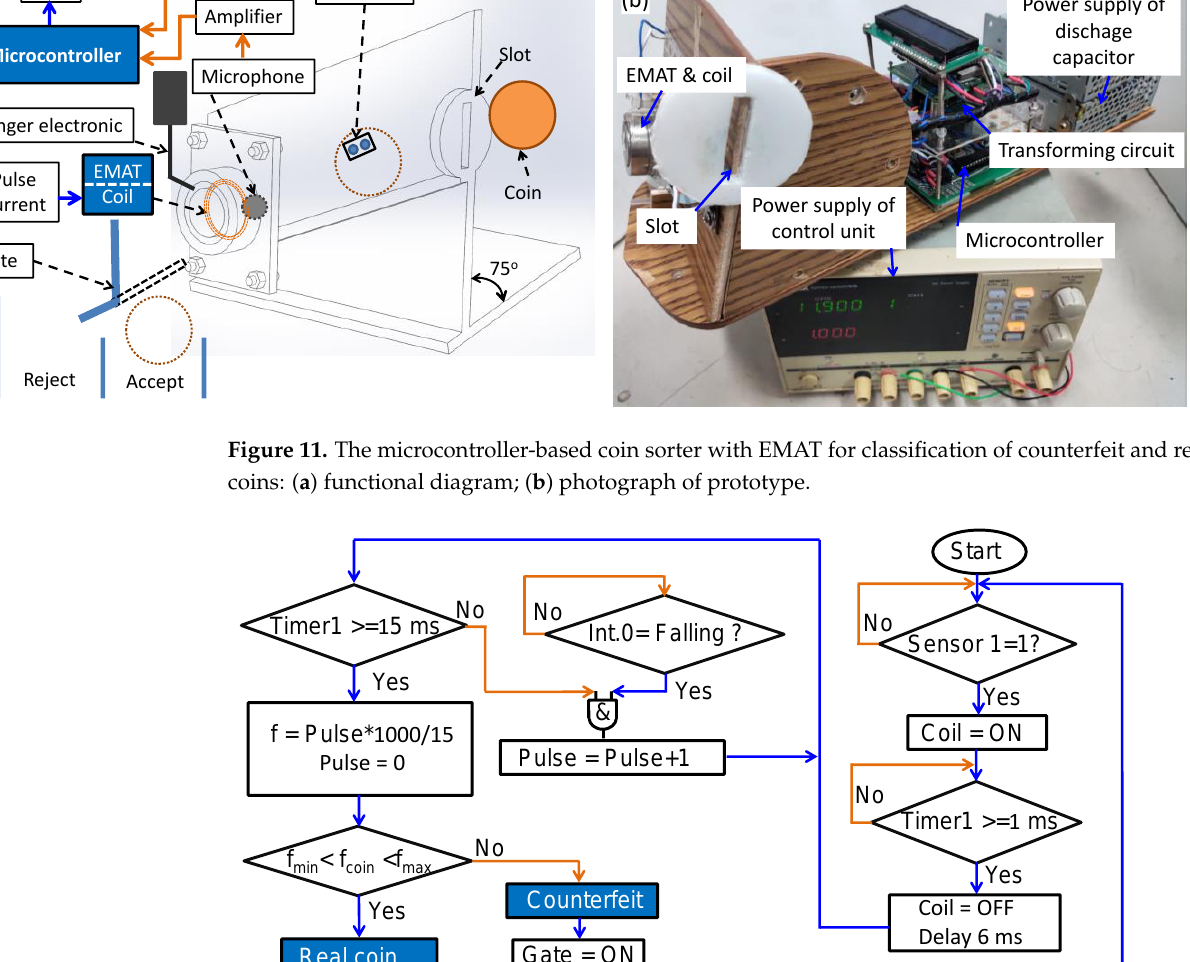
Figure 12. Algorithm of the firmware code in the microcontroller for frequency counting and coin classification.